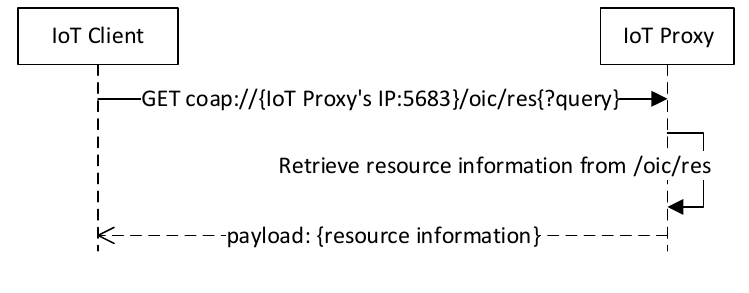
Figure 8. Resource discovery based on IoT proxy.